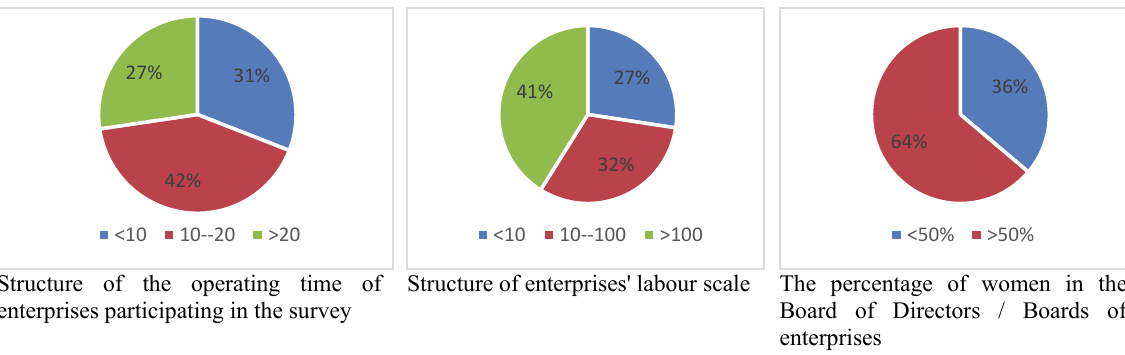
Fig. 3. Personal characteristics of the